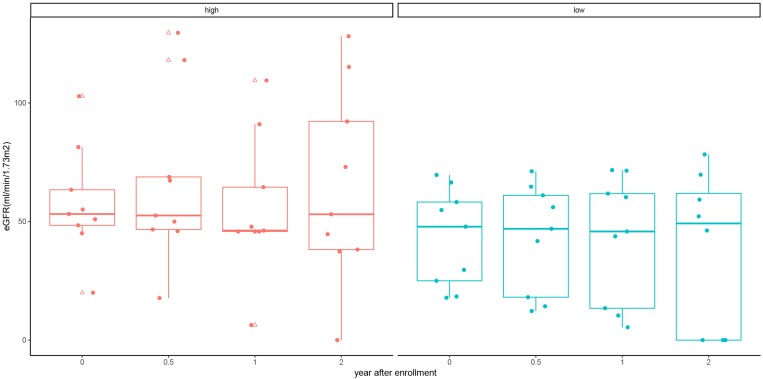
eGFR of kidney allograft recipients with antibody mediated rejection at 6, 12, and 24 months stratified by high and low cfDNA fraction. Solid dots represent true values and triangles represent outliers (> 95th percentile and > 5th percentile).